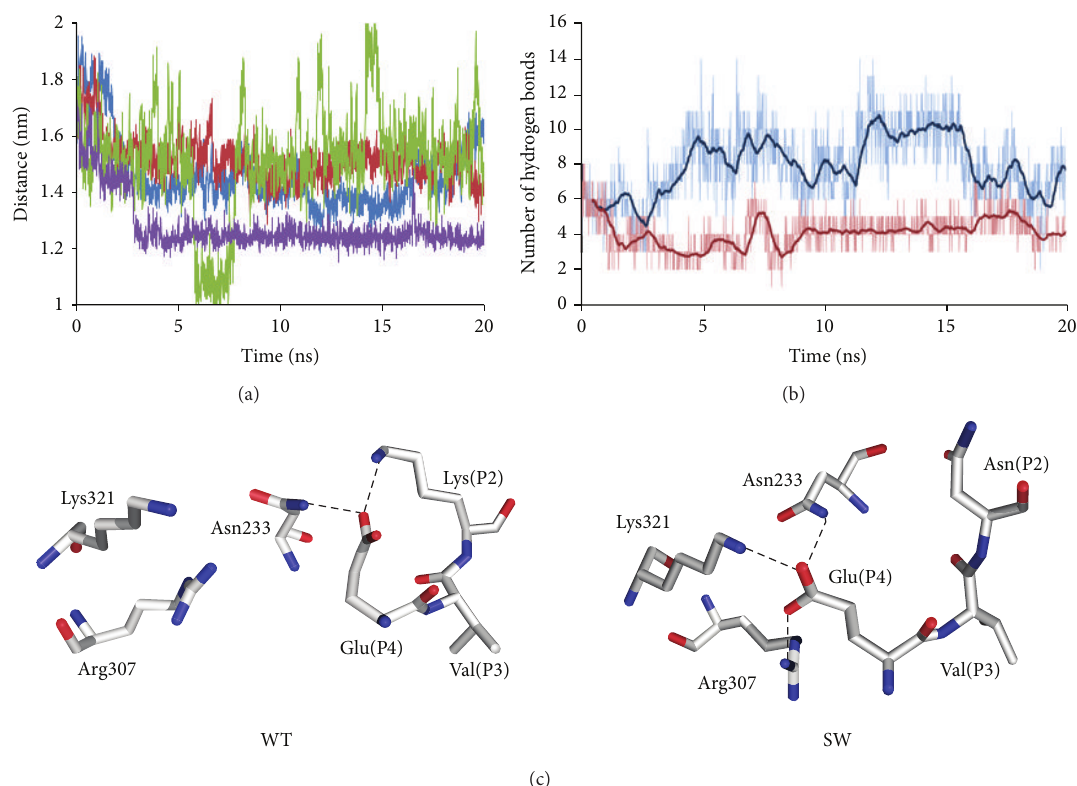
Figure 2: (a) Time evolution of the topological distance between the C 𝛼 (Thr72) of flap tip and C 𝛽 (Asp32) of catalytic dyad (violet: BACE1- compound 11, blue: BACE1-SW substrate, red: BACE1-WT substrate, and green: Apo BACE1). (b) Number of hydrogen bonds formed between the substrates and BACE1 (blue: BACE1-SW substrate, red: BACE1-WT substrate). (c) Interaction of the substrate Glu with the Arg307 of